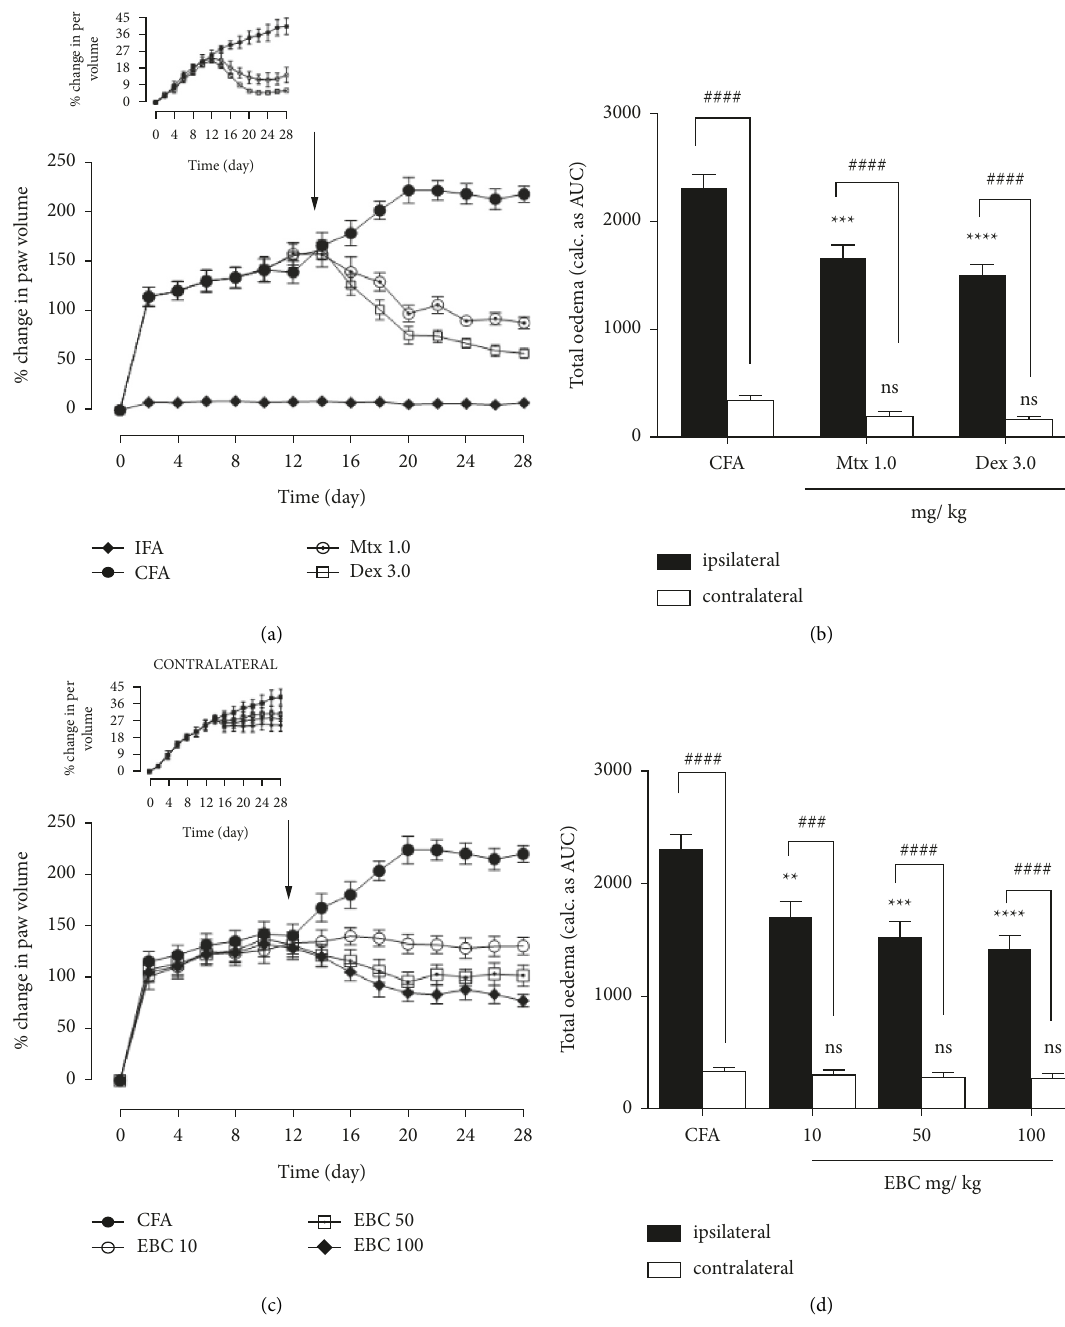
Figure 4: Bombax costatum extract inhibits adjuvant-induced arthritis. Values are mean to contralateral paw (two-way ANOVA followed by Tukey’s post hoc test). compared to the control-treated group (one-way ANOVA followed by Turkey’s post hoc test). Arrow indicates the day of drug